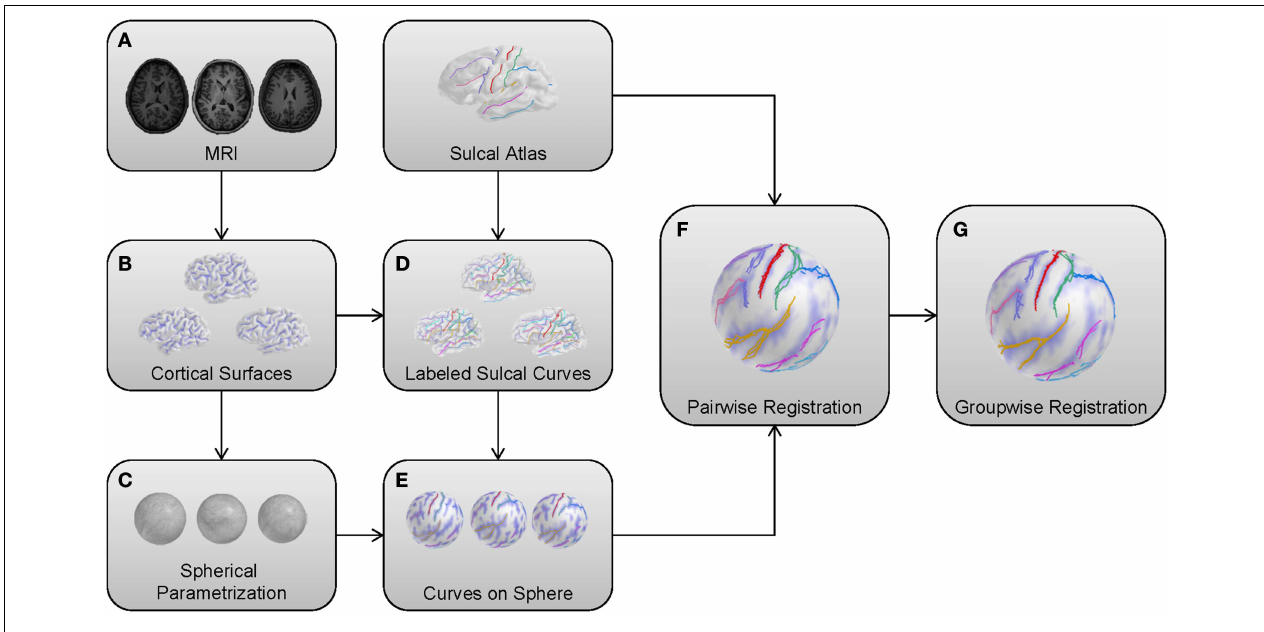
Automatic sulcalcurveextraction andlabeling. (E) Asphericalmapping of labeled sulcalcurves. (F) Pair-wise registration tothe template forindividual correspondence. (G) Group-wiseregistration forunbiasedestimation.